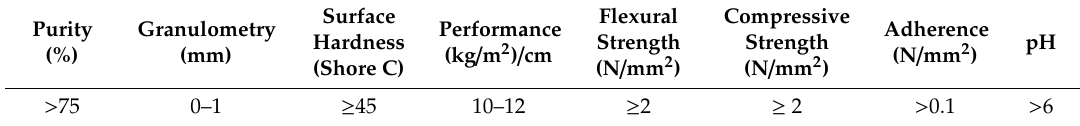
Table 1. Properties of B1 gypsum used as base material.